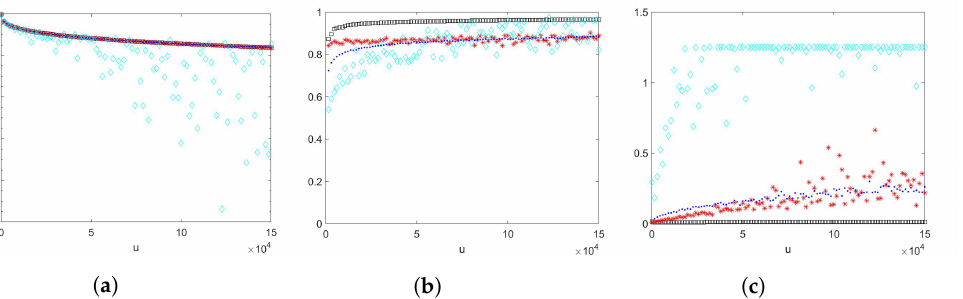
Figure 4. The random variable N is geometrically distributed with success probability p = 0.2, W i i.i.d ∼ Weibull ( 0.35,2 ) , X i i.i.d ∼ Erlang ( 2,3 ) , where i = 1, . . . , N . Black squares: ConAK1+IS+CV (conditioning and IS on Weibull). Red stars: ConAK2+CV (conditioning on Erlang). Blue dots: ConAK2+IS+CV (conditioning and IS on Erlang using an exponential PDF). Cyan diamonds: ConAK2+IS+CV (conditioning and IS on Erlang using an Erlang PDF). ( a ) Estimates of (cid:96) ( u ) as a function of u on a logarithmic scale. ( b ) Empirical logarithmic rates as a function of u . ( c ) Empirical relative errors as a function of u